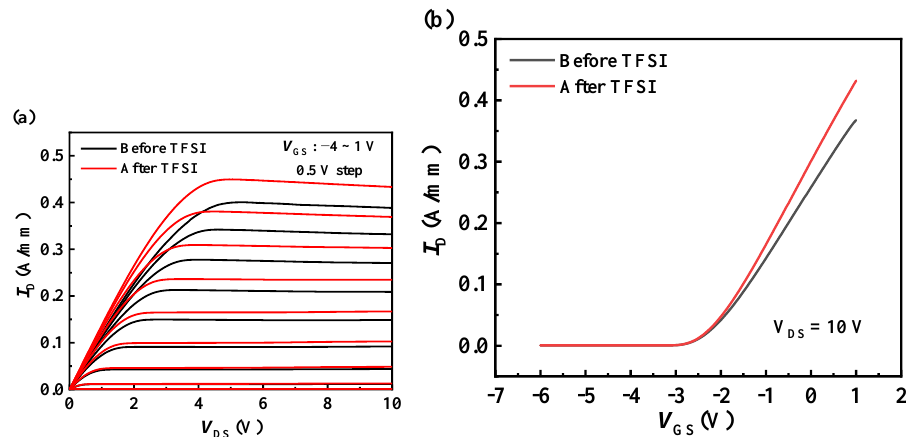
Figure 3. ( a ) I - V output characteristics of InAlN/GaN HEMT before and after TFSI treatment; ( b ) Transfer characteristics at V DS = 10 V of InAlN/GaN HEMT before and after TFSI treatment.